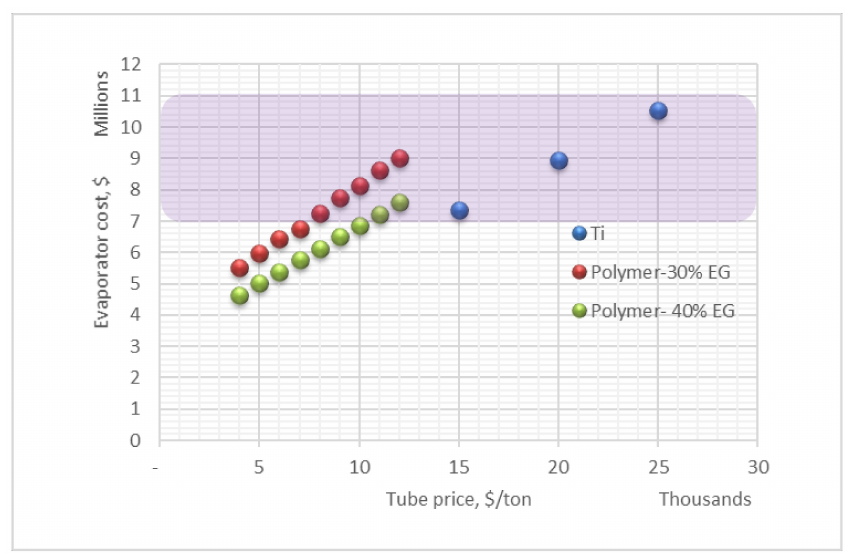
Figure 8. Evaporator cost (shell + tube) at different polymer-tube prices.